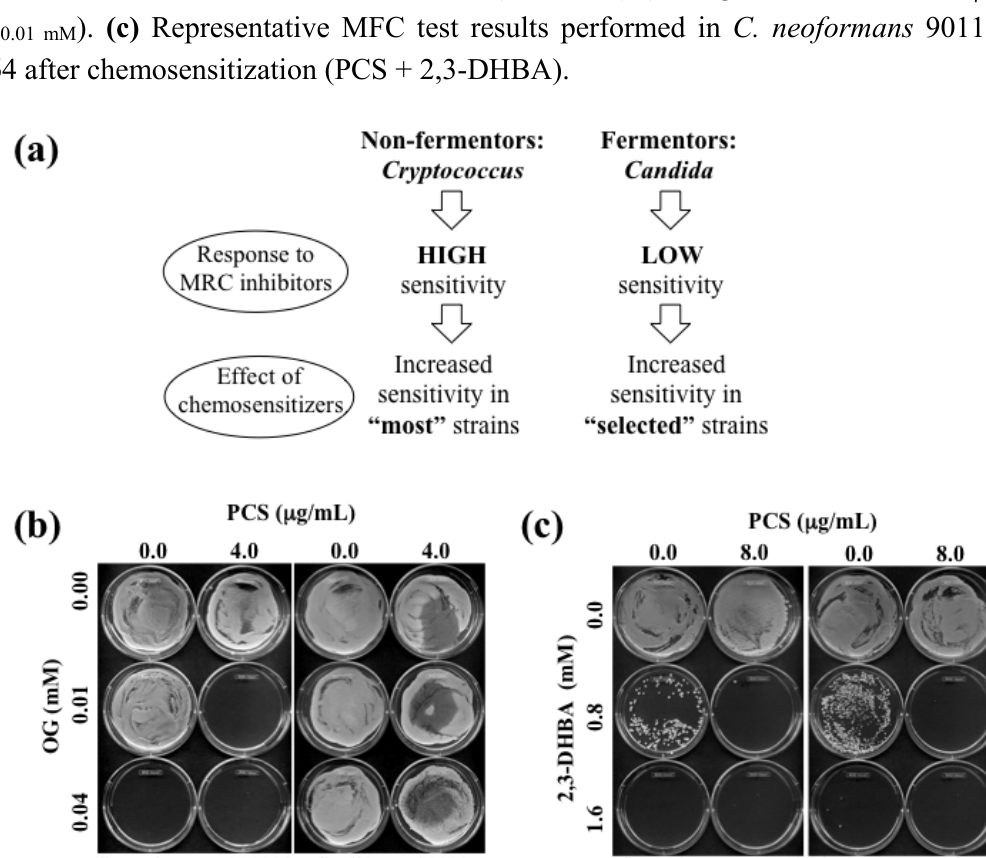
+ OG ) to the 4.0 μ g/mL 0.01 mM + 4.0 μ g/mL